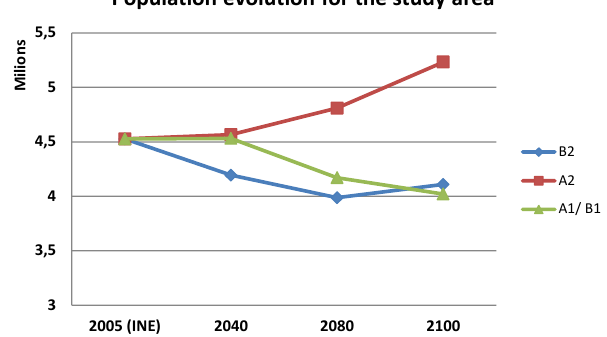
Figure 5 - Population local scenarios. Source: Adaptaclima-EPAL project report (2011). Figure 5. Population local scenarios. Source: Adaptaclima-EPAL project report The main trends of the SRES for land use changes in Europe have been identified in several publications (e.g. Schröter et al., 2005; Verburg el al., 2006; Rounsevell et al., 2006; IPCC, 2007) and are summarised in Table 3. All scenarios, but especially A1, show a significant reduction in agricultural area and an increase in urban area.